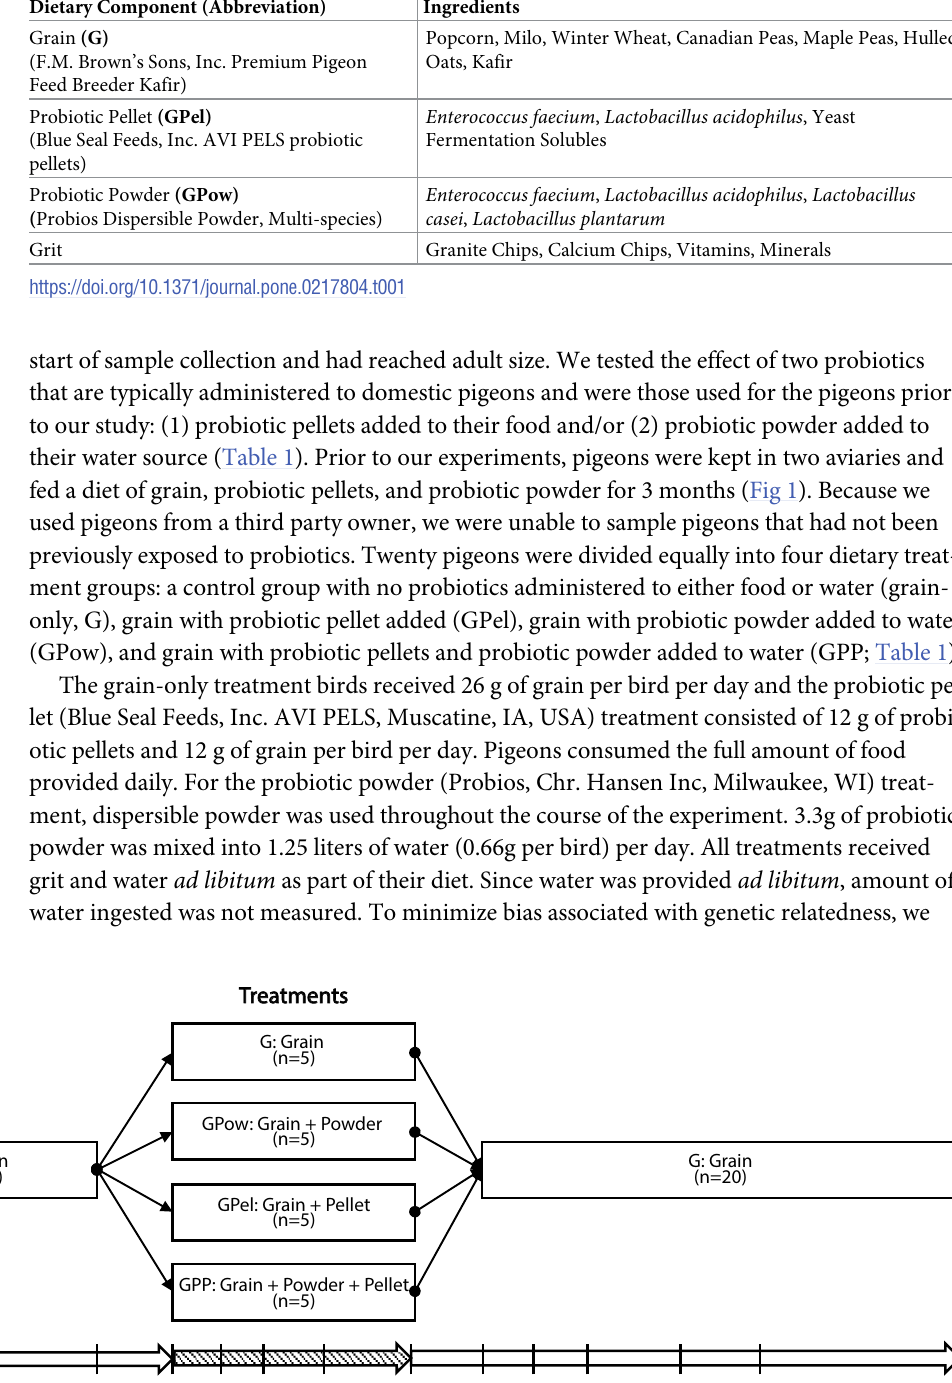
Table 1. Dietary composition of pigeon food and probiotics according to the manufacturer. Dietary Component (Abbreviation) Ingredients